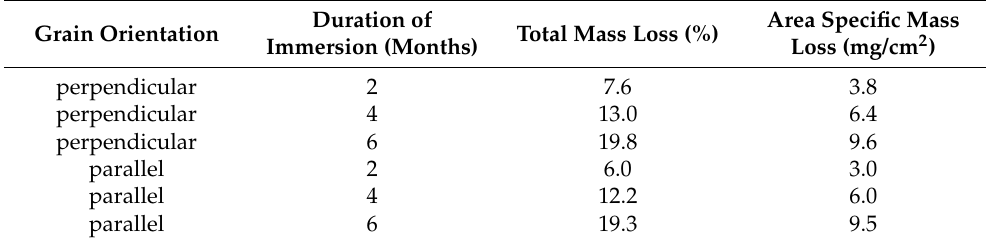
Table 1. Total mass loss and area-specific mass loss of molybdenum sheet metal samples in 2–6 months of immersion in Kokubo’s SBF.